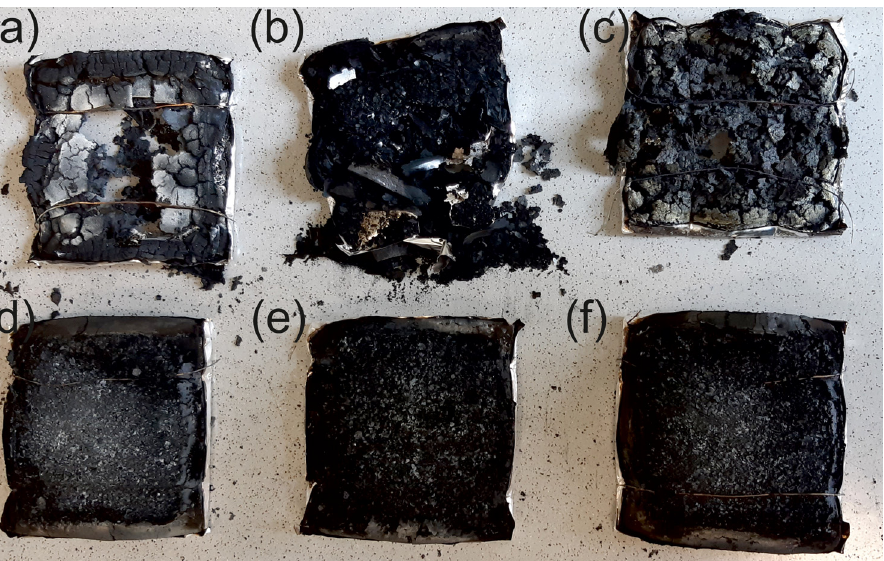
Figure 12: Sample residues after cone calorimeter measurements. ( a ) BR/CR/CB20, ( b ) BR/CR/ATH50/CB20, ( c ) BR/CR/MLG3/CB5, ( d ) BR/CR/ATH50/MLG3/CB5, ( e ) BR/CR/ATH47/MLG3/CB20, and ( f )